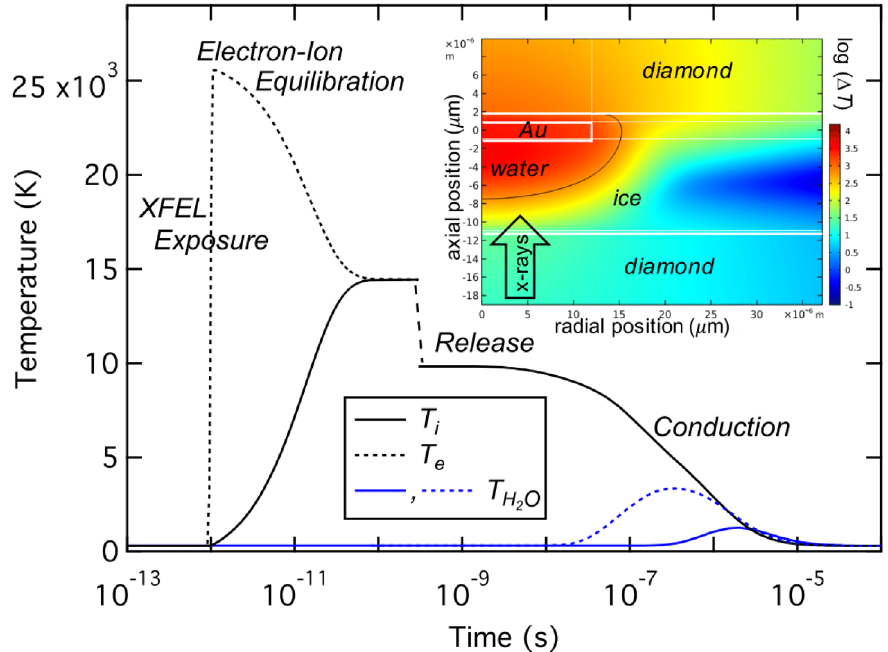
Fig. 5 Calculated temperature – time history of the Au sample. The graph shows the simulated temperature of sample #2 at 4.7 GPa after a 48.6 µ J pulse (see Supplementary Table S1), showing sample temperature on the beam axis, at the center of the Au foil (black dotted and solid lines for electron and ion temperature, respectively) and in the water bulk 0.5 and 2 µ m upstream from the foil (blue dashed and solid lines, respectively). The XFEL pulse of 25 fs duration strikes the sample at 10 − 12 s, producing a sharp jump in local electron temperature, which reaches equilibrium with the cold ions on ps timescales 37 at constant volume conditions. Following a rapid expansion cooling of the sample, heat conducts out of the sample and into the surrounding cold diamonds at constant pressure 23 . The inset shows the temperature distribution and maximum extent of water melting after heating at full power (320 µ J/pulse) on sample #1 at 52 GPa (Supplementary Fig.